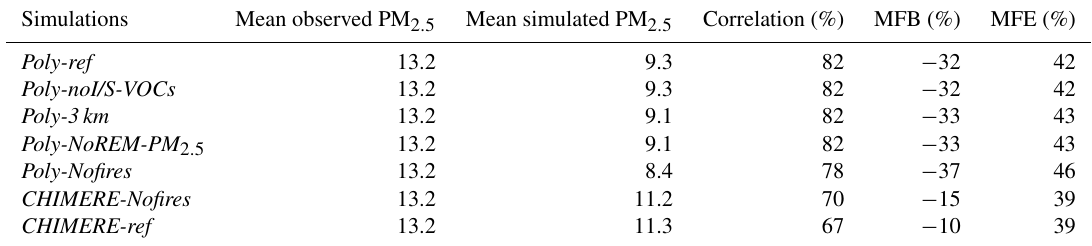
Table 3. Statistics of models-to-measurements comparisons for the mean daily PM 2 . 5 concentrations during the summer of 2007 (AIRBASE station number = 8).